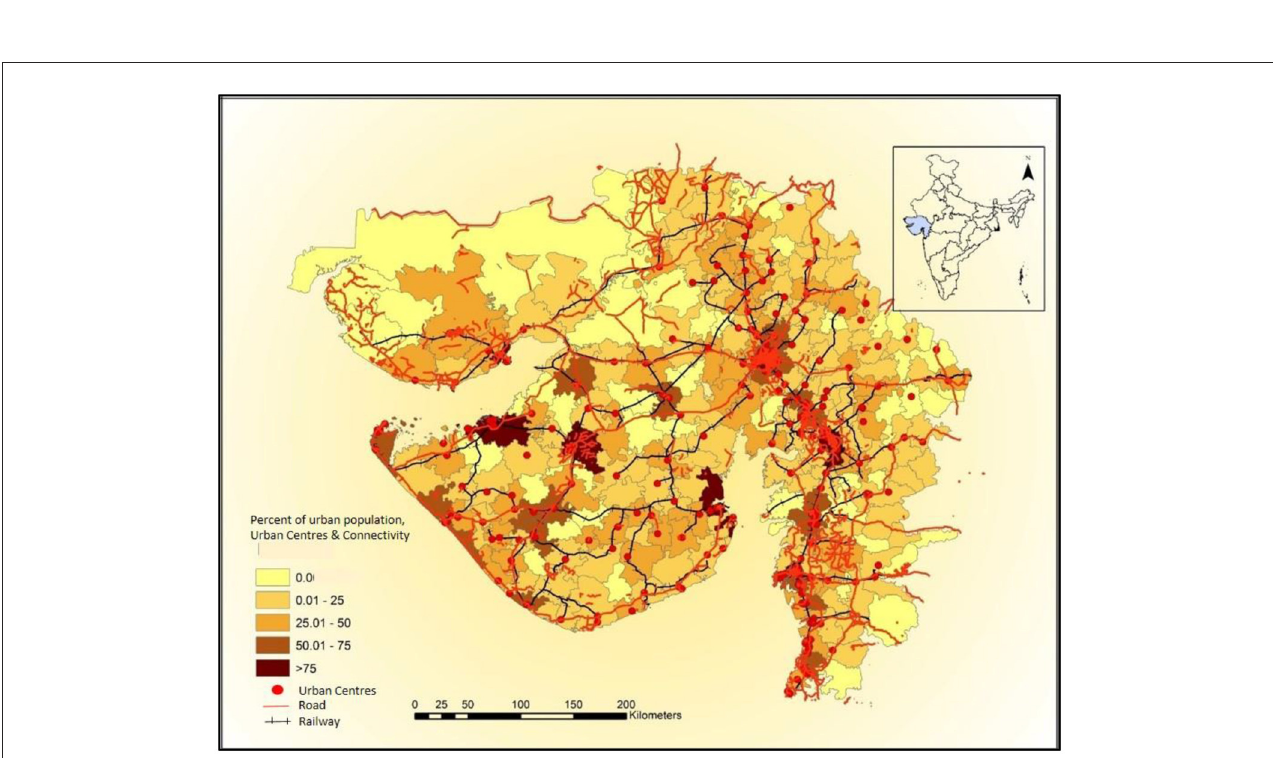
FIGURE6 Distribution of census towns in Gujarat-2011. Source: Prepared by the Authors,